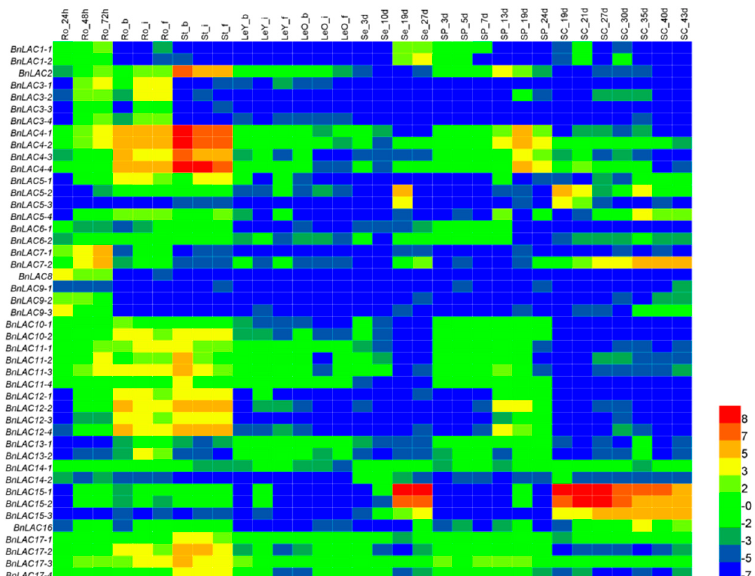
Figure 7. RNA-seq of BnLACs in B. napus 32 different tissues and stages. Ro, root; St, stem; LeY, young leaf; LeO, old leaf; Se, seed; SP, silique pericarp; SC, seed coat; s, seedling stage; b, bud stage; i, initial flowering stage; and, f, full-bloom stage. The 24, 48, and 72 h means the time that had passed after seed germination. The 3, 10, 27 d and other indicate the number of DAF. The bar on the lower right corner represents the Fragments Per Kilobase of Transcript Per Million Fragments Mapped (FPKM) values and different colors represent different expression levels. Heat map was generated by HemI 1.0 software (http://hemi.biocuckoo.org/faq.php).